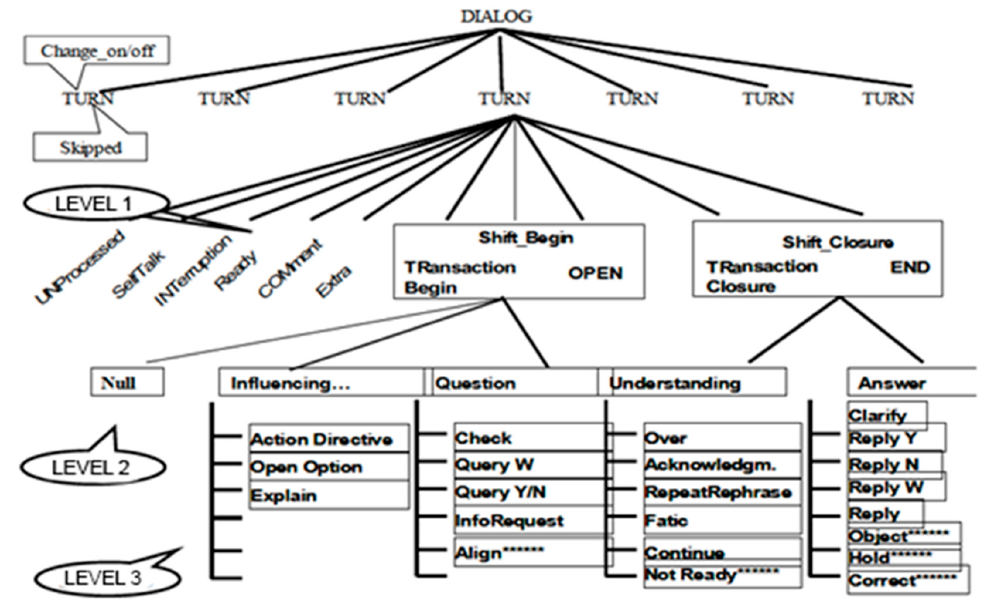
Figure 1. Graphic representation of the Pra.Ti.D model (Castagneto,